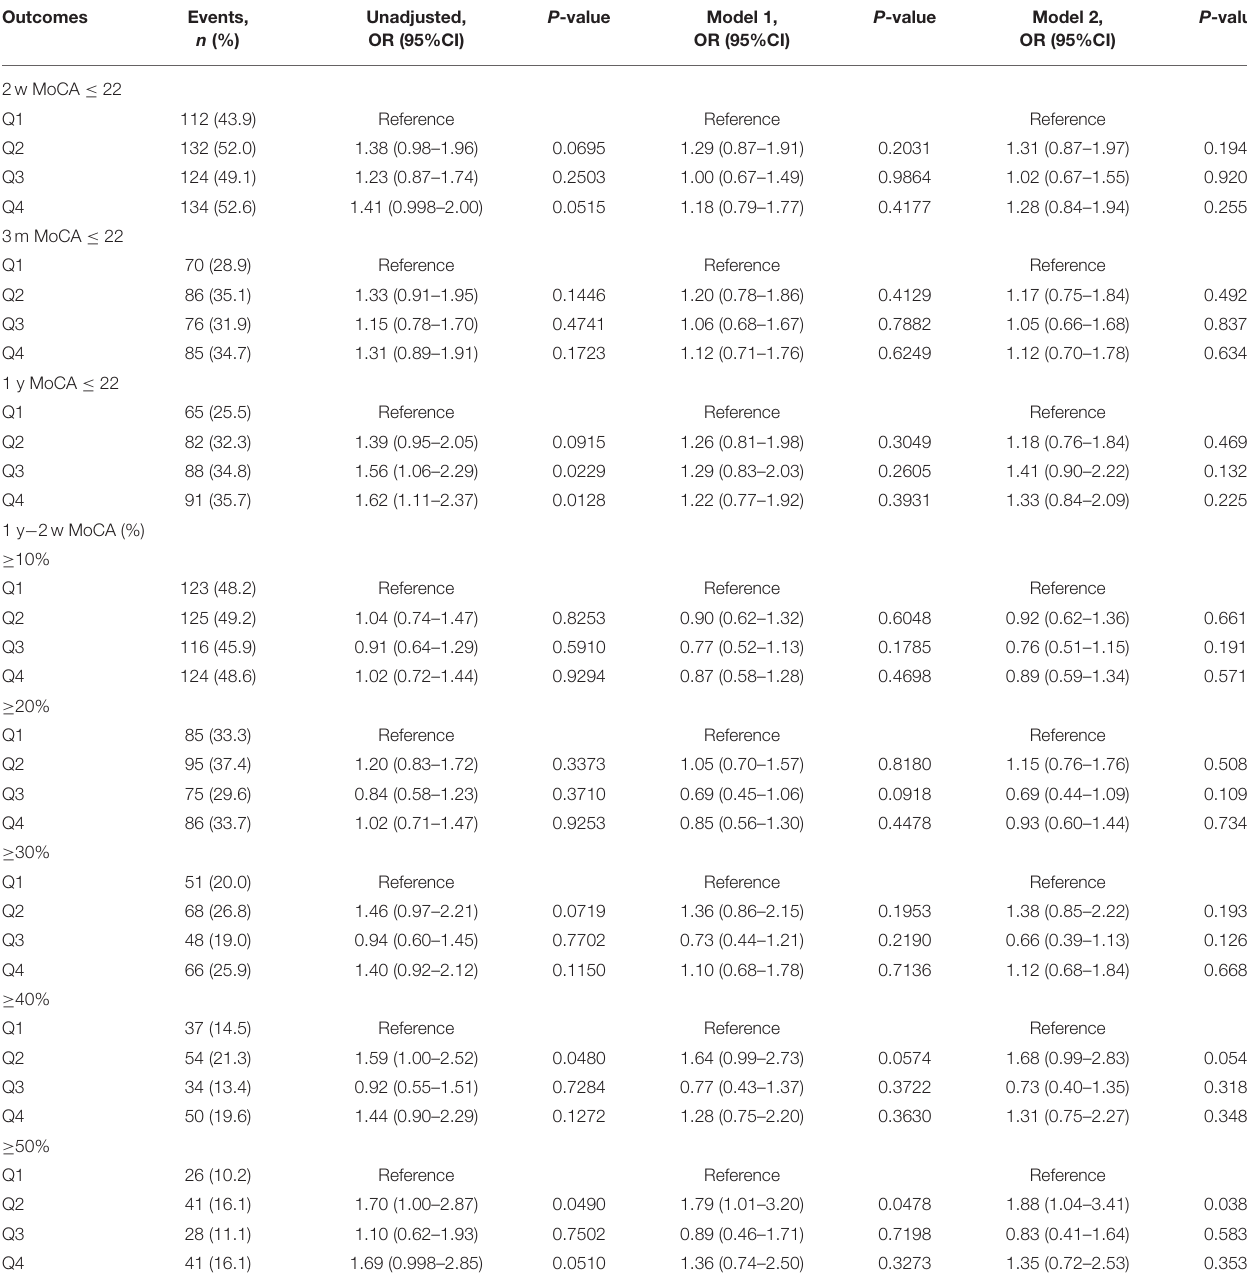
TABLE 2 | ORs of Lp (a) levels for cognitive impairment at 1